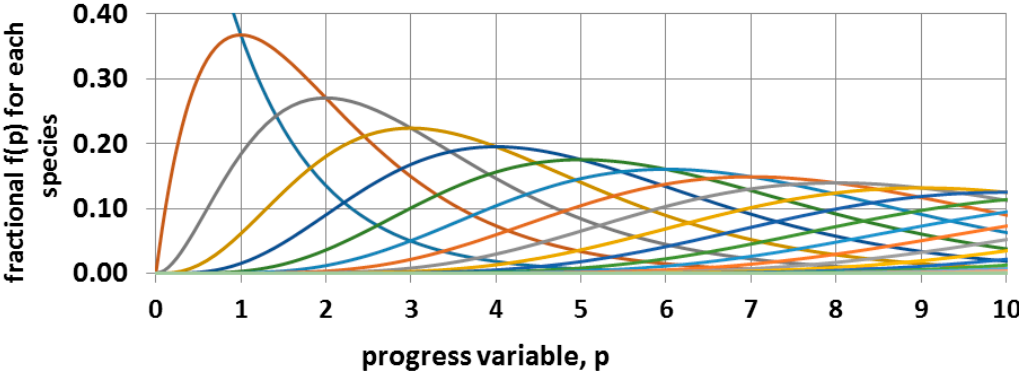
Figure 12. Irreversible sequential second order kinetics. The blue decreasing curve is for the monomer.